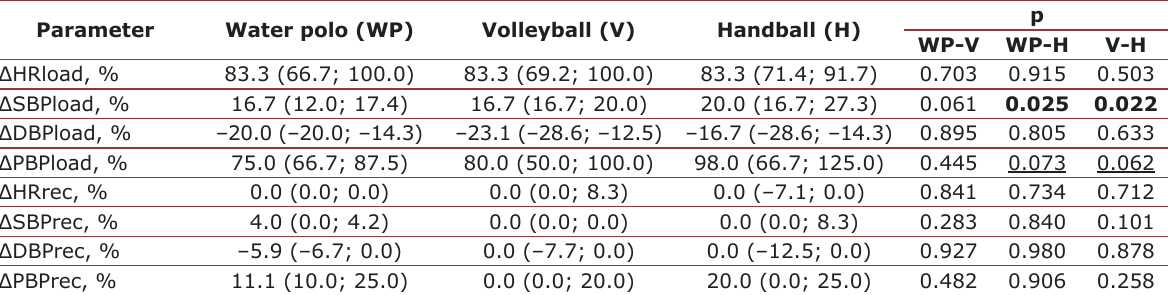
Fig. 2. Graphs of changes in average indicators of HR (a), SBP (b), DBP (c) and PBP (d) in game sports athletes during performing the Martine Table 3. Average parameters of the increase in indicators of the athletes cardiovascular system immedi- ately and at the end of the third minute of recovery after a standard load, %, M (25; 75)